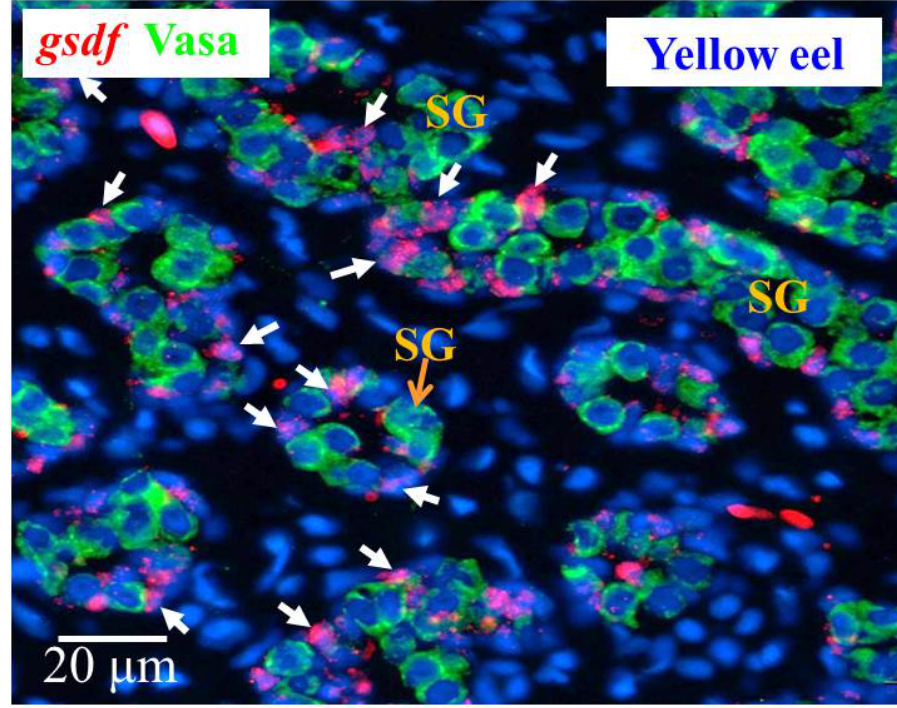
Figure 7. Cellular localization of gsdf transcripts and Vasa proteins in the yellow Japanese eel. gsdf transcripts (red) in the testis of the yellow eel as revealed by in situ hybridization (ISH) in Sertoli cells (white arrow). Vasa proteins (green) as revealed by immunohistochemistry (IHC) on the same sections. SG, spermatogonia cells.